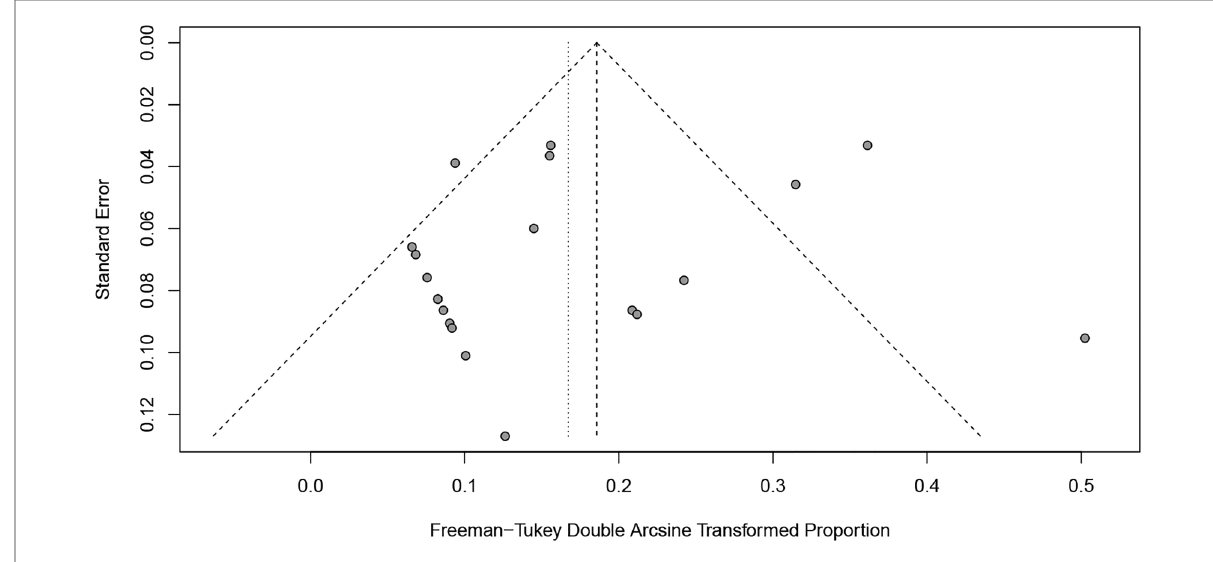
FIGURE 2 Funnel plot for the re-revision rate of retained stems for any reason.